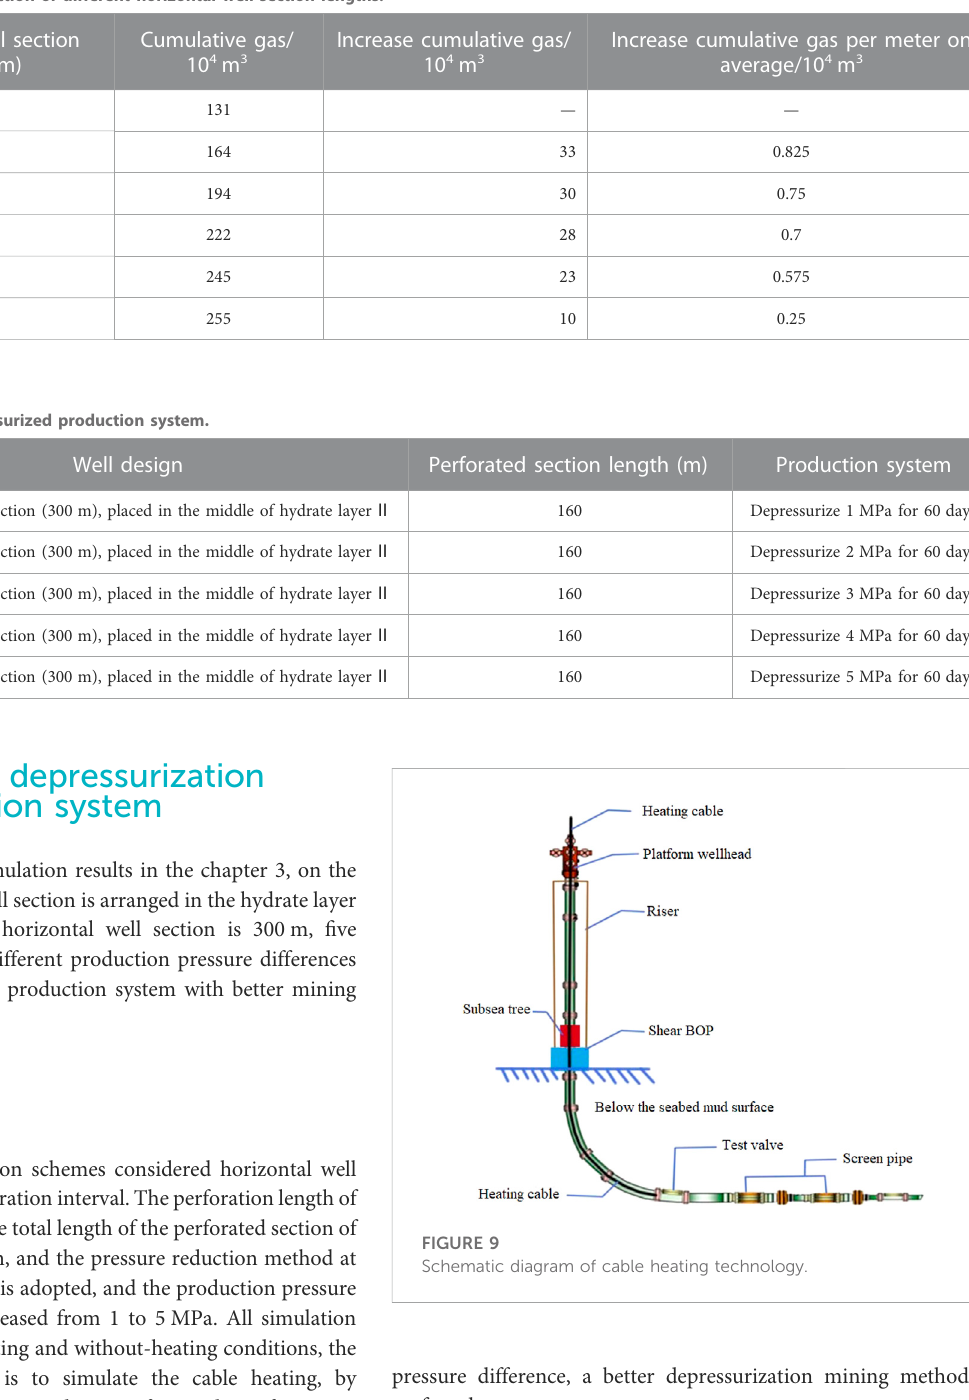
TABLE 5 Analysis of gas production of different horizontal well section lengths.